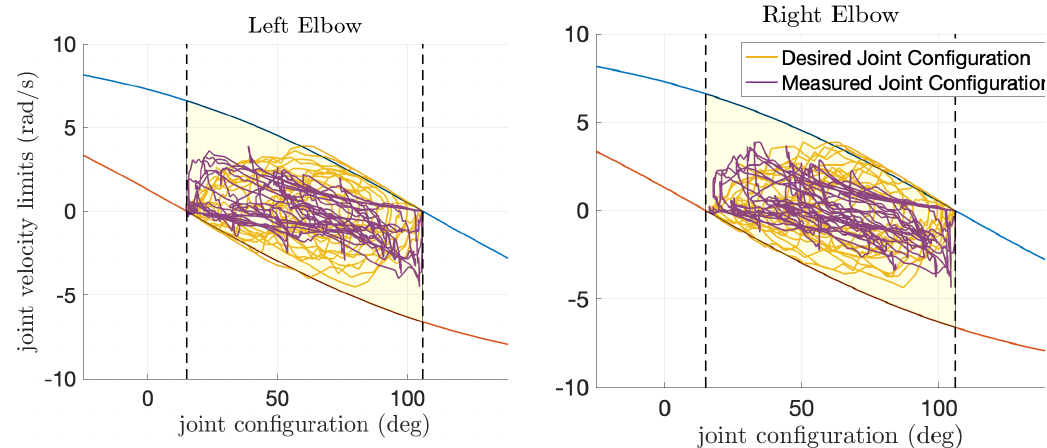
Figure 3. Constrained configuration space for the elbow joints of the iCub model. Blue and red lines represent respectively upper and lower joint velocity limits, depending on joint angle. The yellow area represents the joint configuration space. According to limit avoidance strategy, the joint velocity is bounded to be ≥ 0 when lower angle limit is reached, and ≤ 0 when upper limit is reached (angle limits are represented by dashed lines). Yellow lines represent the joint configuration trajectory computed via inverse kinematics algorithm, while the purple line represents the trajectory tracked by a real